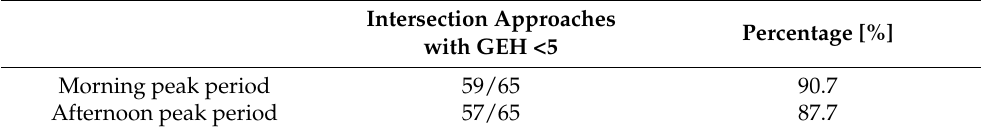
Table 1. Validation of microsimulation model using GEH statistics.